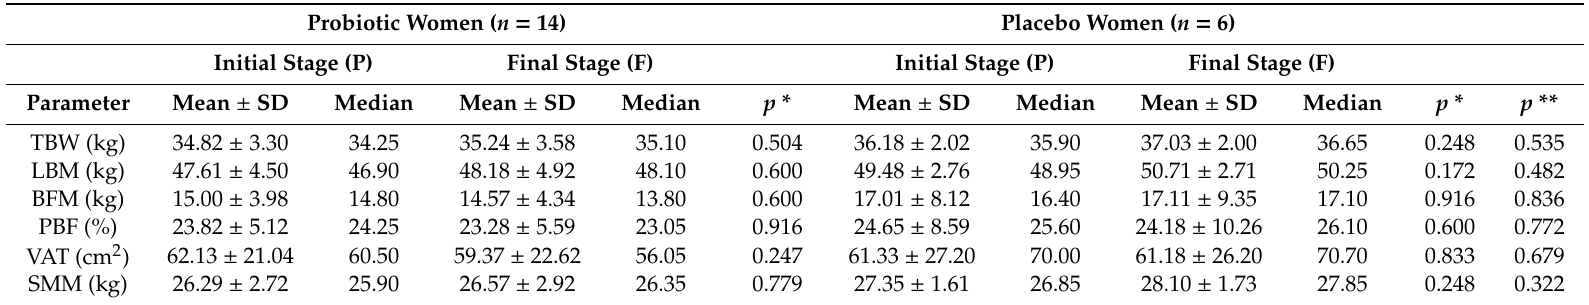
Table 1. Comparison of body composition variables of women from the study and control groups at the initial and final stages of intervention.